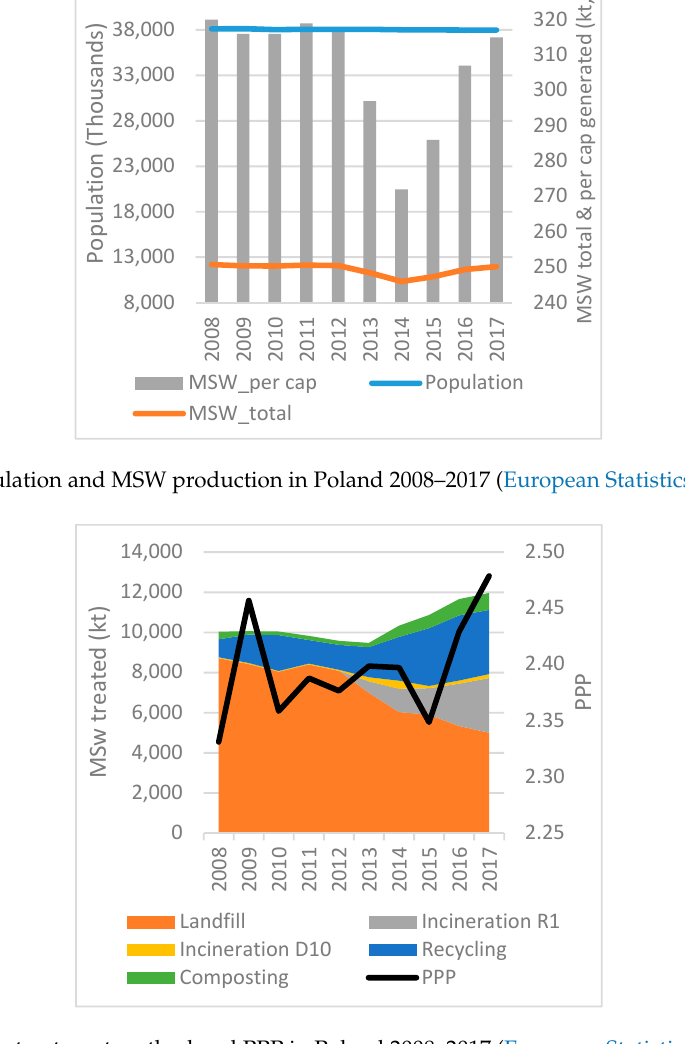
Figure 42. Waste treatment method and PPP in Poland 2008–2017 (EUROSTAT 2019b, 2019c).